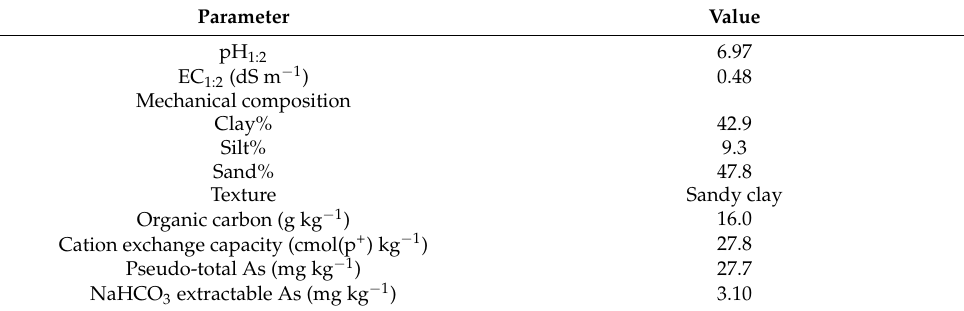
Table 1. Initial characteristics of the experimental